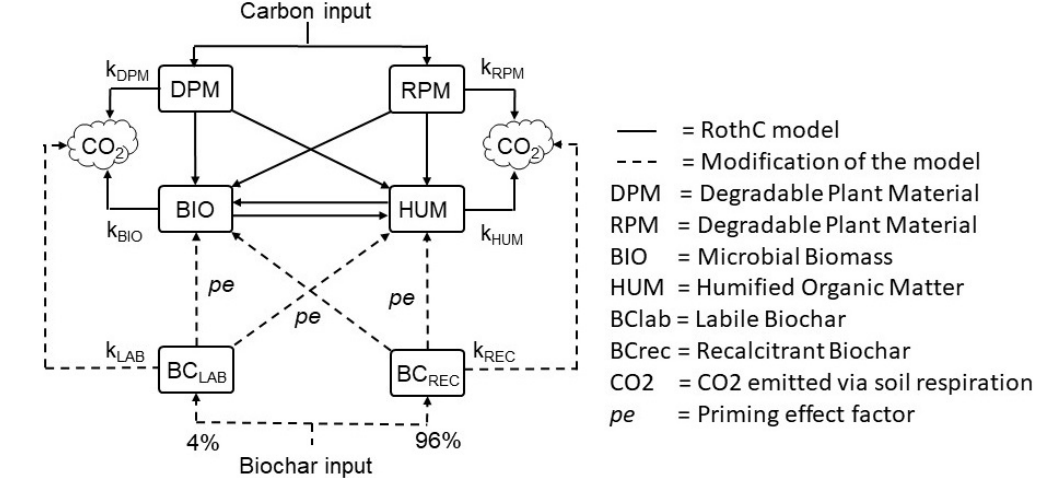
Figure 1. Modification of the RothC model with the inclusion of labile and recalcitrant biochar pools and the priming effect on BIO and HUM. The CO 2 pool is assumed to be comparable to soil heterotrophic